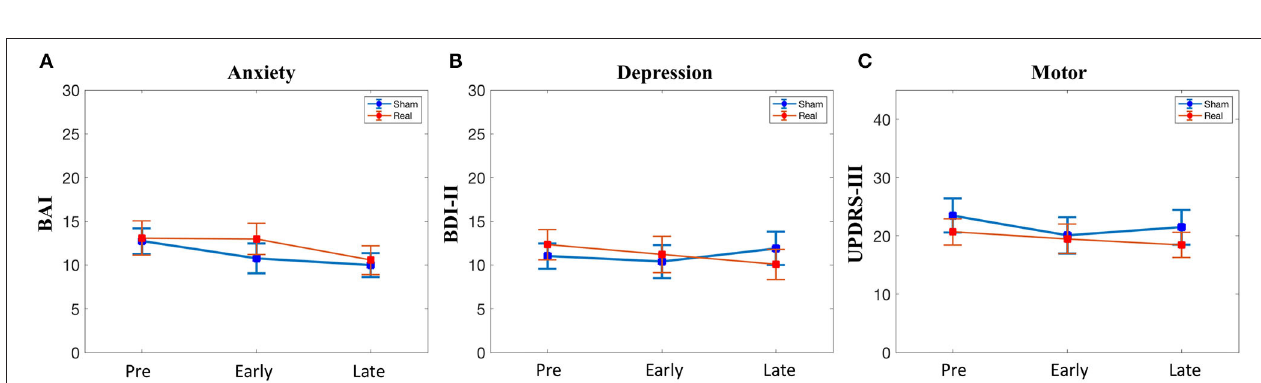
FIGURE 3 | Cognitive scores across time (pre-stimulation, early (24h after stimulation), late (1 month after stimulation). (A) Global cognition. (B) Executive function. (C) Language. (D) Attention. (E) Memory. (F) Visuospatial. See Supplementary Table 4 for details.